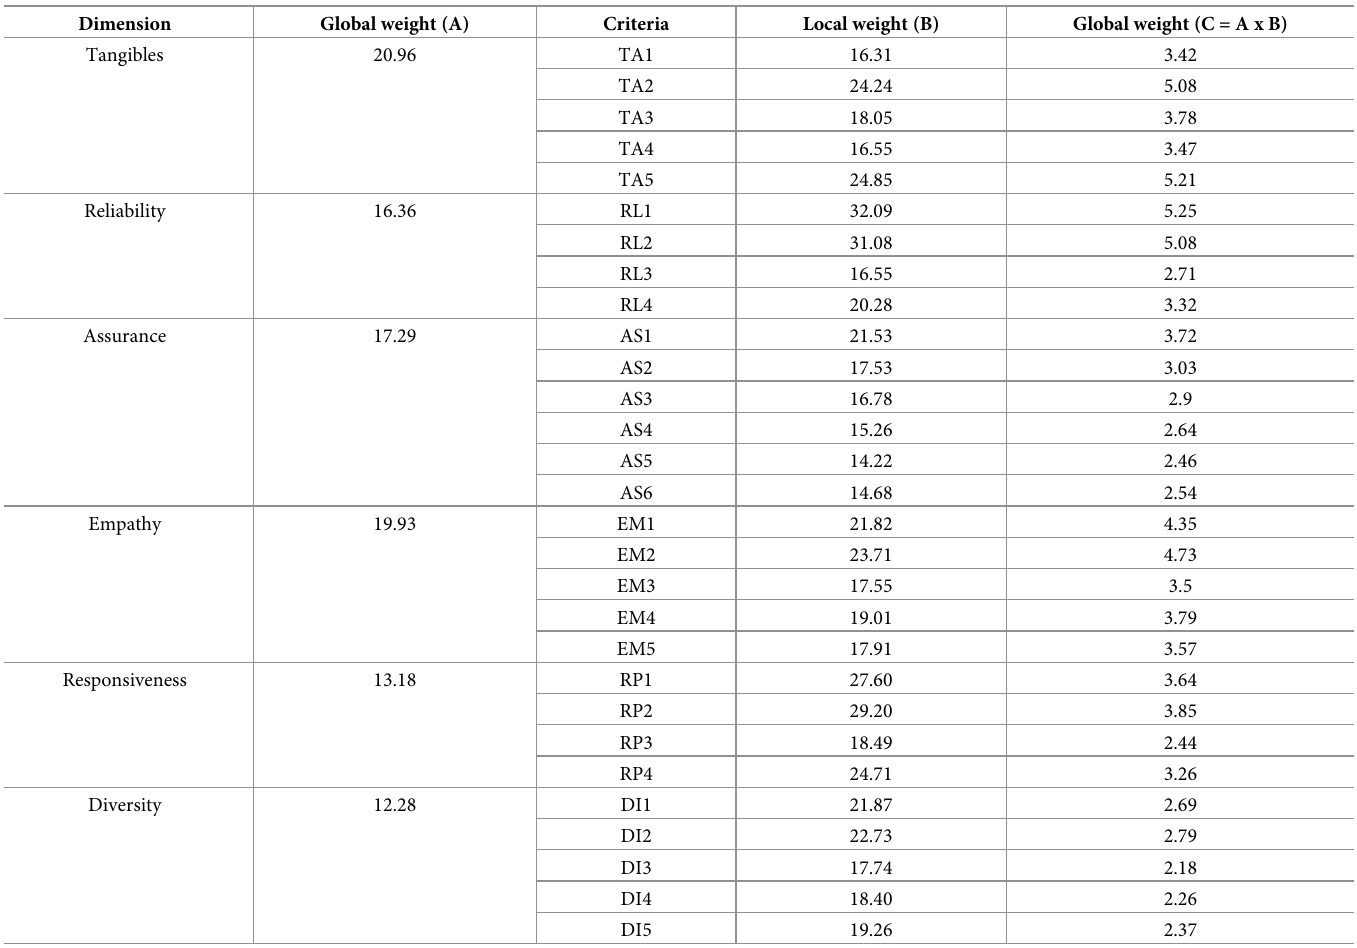
Table 9. The revised weights of SAs for satisfaction measurement